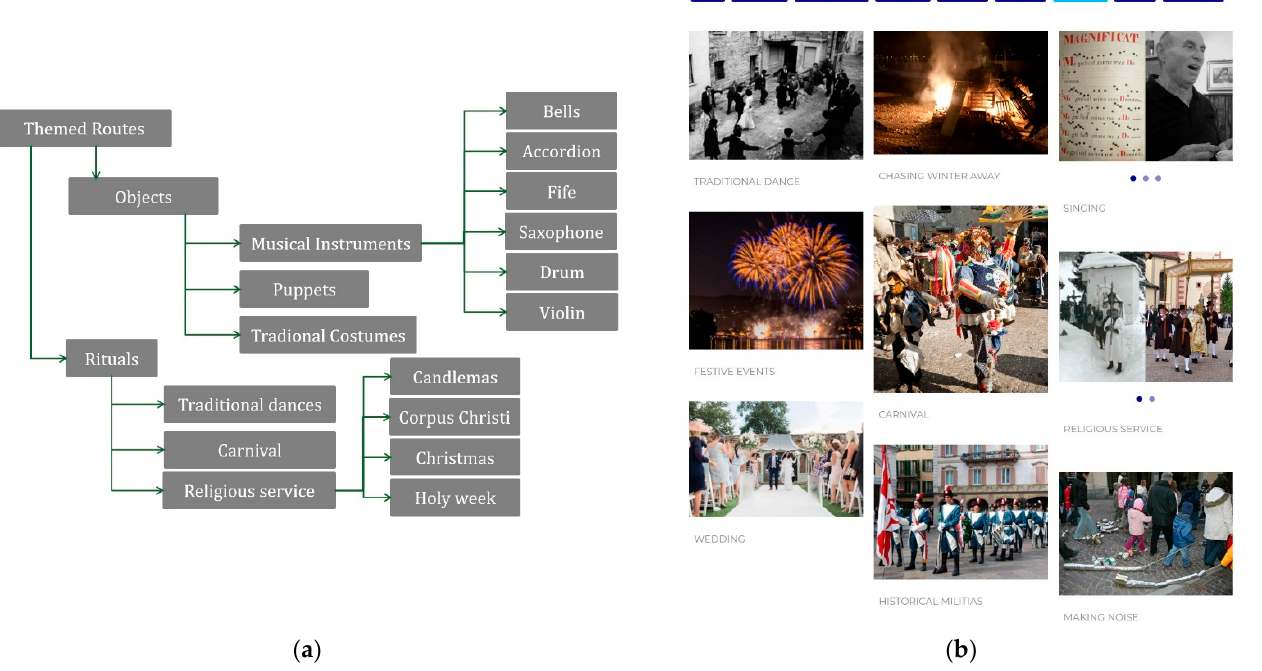
Figure 7. Themed routes: ( a ) keywords structured by experts; ( b ) the theme “Rituals” with graphic presentation.